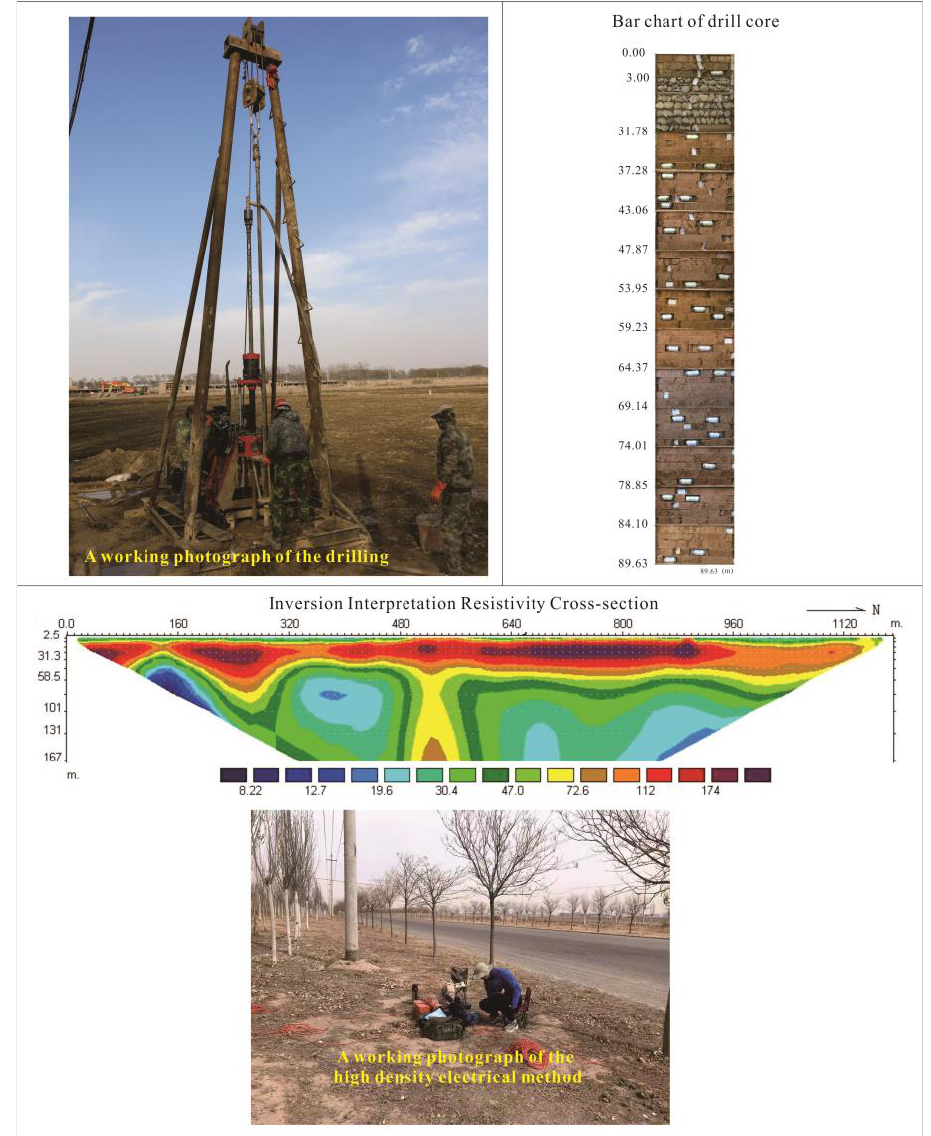
Figure 2. Fieldwork in drilling and high-density electrical prospecting.